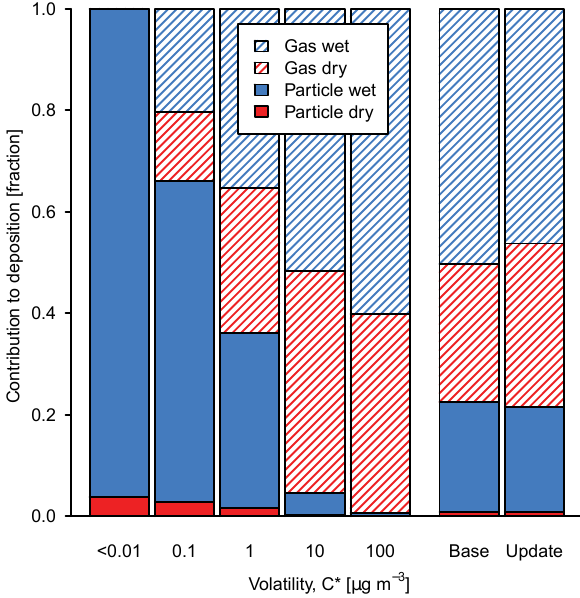
Figure 5. Contribution of wet (blue) and dry (red) deposition of gas (striped) and particle (solid) SVOCs binned by volatility and overall compared to the base simulation (CMAQ v5.1). Nonvolatile species are indicated by C ∗ < 0 . 01µgm − 3 . POA is not